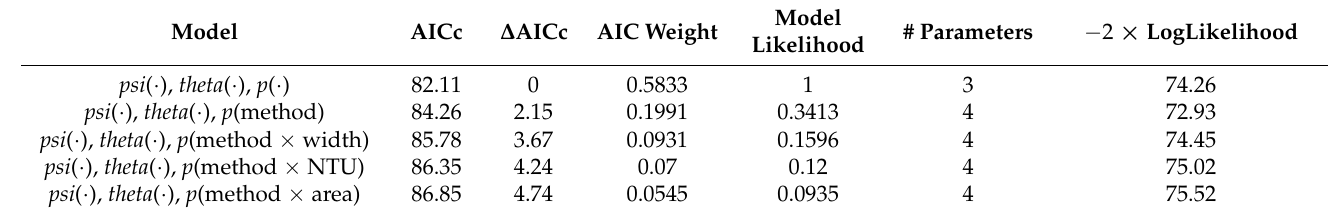
Table 2. Model selection results for multi-scale single season occupancy models comparing models where occupancy ( psi ) was held constant. Sub-reach scale occupancy ( theta ) was held constant. Detection probability ( p ) estimates were either held constant, varied between eDNA and visual surveys, or modeled with a covariate. Data used in this analysis included the 13 mainstem sites that were not on the contaminated Plate 5 and the four downstream tributary sites. AICc = Akaike Information Criterion for small sample sizes.